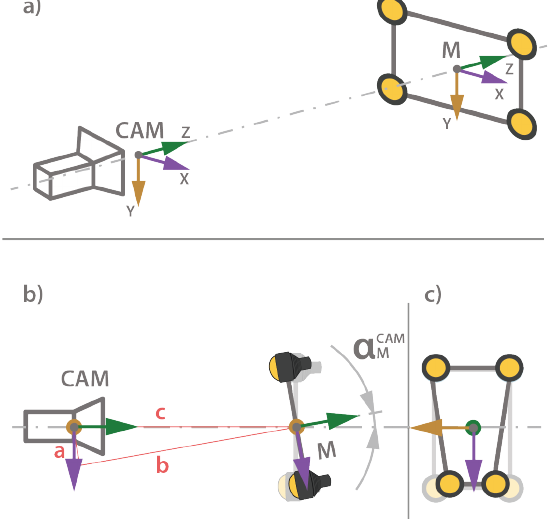
Figure 7. The camera and light marker coordinate systems ( a ), relative heading α Cam acquisition camera and light marker ( b ), maps as a perspective distortion of light beacons in camera projection plane ( c